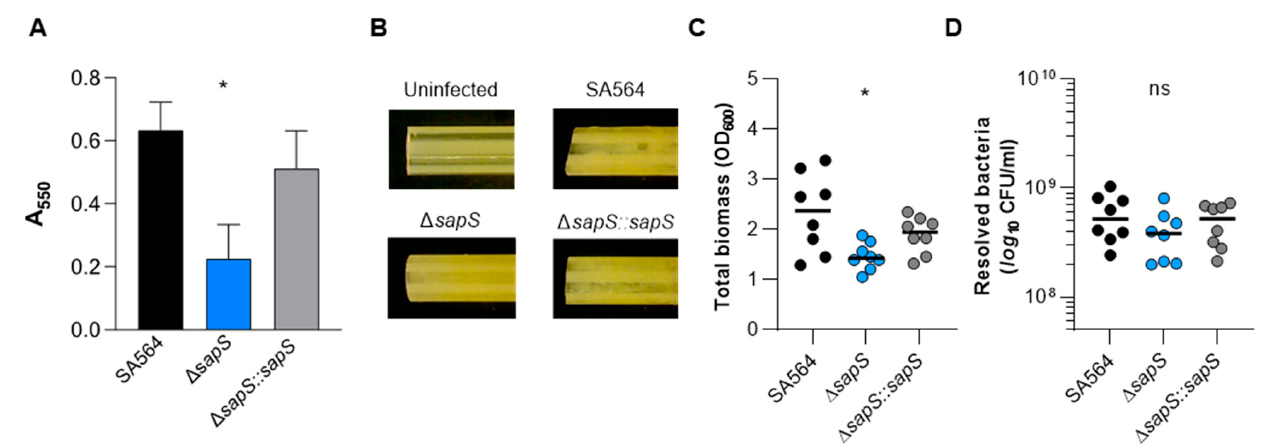
Figure 10. Impact of a sapS deletion on S. aureus SA564 ability to produce biofilms. ( A ) Cells of S. aureus SA564 (black), SA564 ∆ sapS (blue), and SA564 ∆ sapS::sapS (grey) were cultivated in BHI for 48 h at 37 ◦ C in a humid atmosphere using 96-well microtiter plates. The crystal violet assay was used to evaluate the entire biofilm formation. The optical density (550 nm) and the production of biofilm are directly correlated. The presentation includes the means as well as the standard errors for a total of six different replicates. ( B – D ) Influence of SapS on the ability of S. aureus SA564 to build biofilms on medical devices. ( B ) Photographs of fragments of S. aureus -loaded peripheral venous catheters (PVC) taken on day 5 after the initial inoculation (6.3-fold magnification). These findings are indicative of three separate tests. An uninfected PVC fragment incubated for 5 days in sterile medium served as control. ( C , D ) Total biomass and CFU rates of detached biofilms were calculated by measuring the OD 600 of the TSB solutions ( B ) and plate counting ( D ). The values of each individual experiment are represented by symbols, along with the median value (horizontal line) (n = 8). *, p < 0.05; ns, not significant (Kruskal–Wallis test and Dunn’s post hoc test, only the changes between SA564 and mutants are displayed).